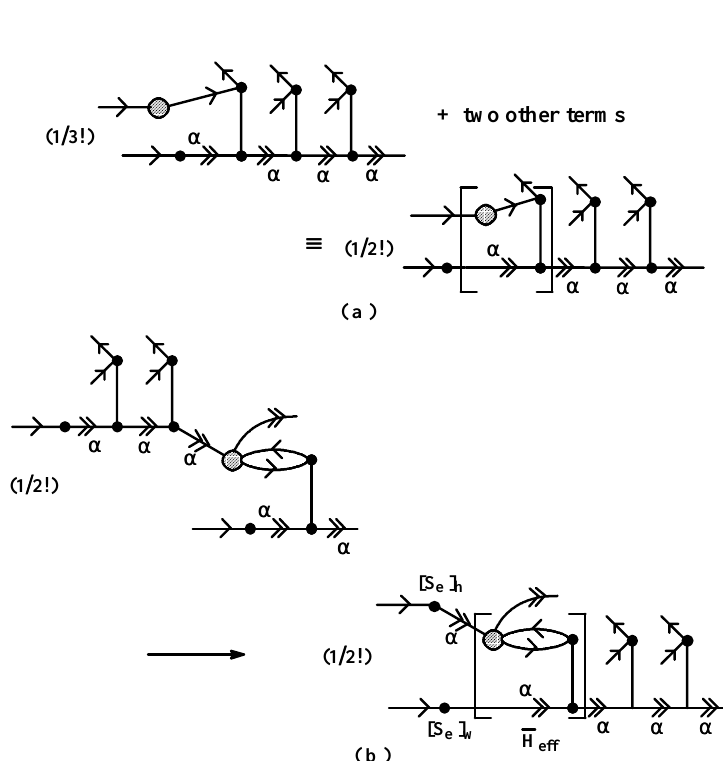
Figure 3: (a) Overall contribution from three diagrams of the same topology. The skeleton in the braces is the strongly connected ‘ X ’ operator. (b) Moving the weakly connected S r operator on the left of H eff to its right, yielding the same contribution. The quantity in the braces is the H eff